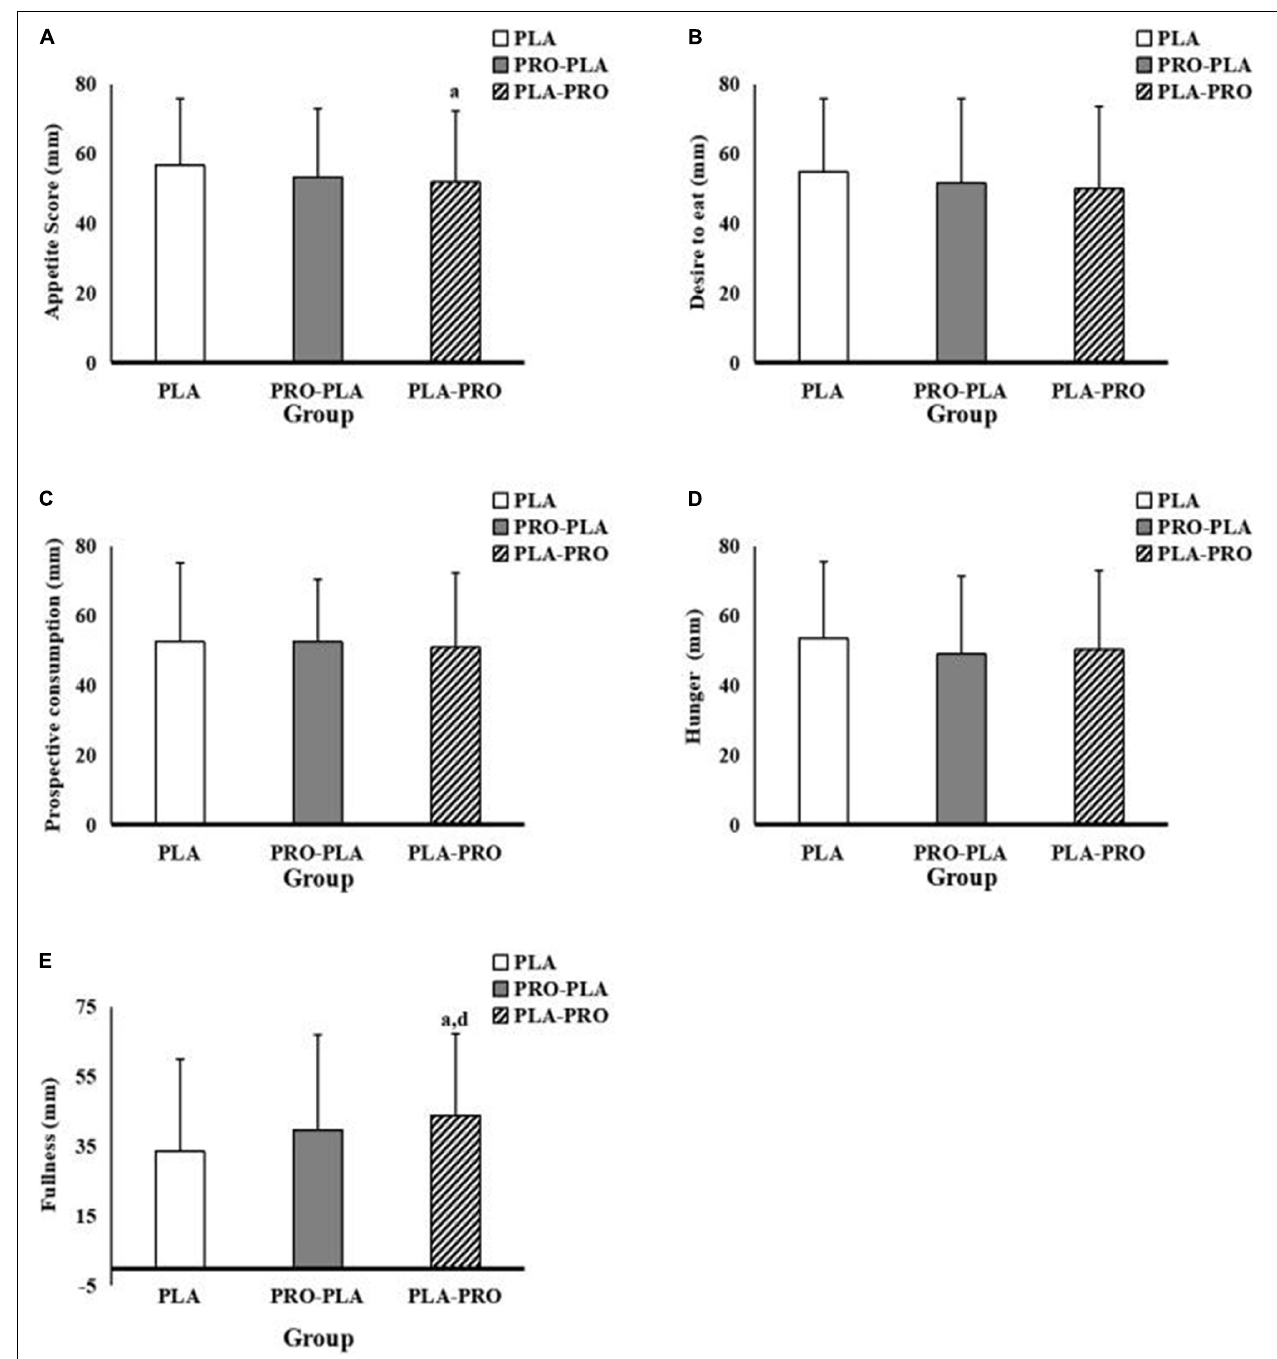
FIGURE 5 | Appetite scores in PLA, PRO-PLA, and PLA-PRO (unit: mm). (A) The appetite score. (B) Desire to eat. (C) Prospective consumption. (D) Hunger. (E) Fullness. a p < 0.05 PLA-PRO VS PLA, adjusted for age, sex, %fat, relativeVO 2max sleep quality, the time of sedentary behavior and moderate and vigorous intensity physical activity in the pre-experiment stage, resistance energy expenditure under each condition (model 1); d p < 0.05 PLA-PRO VS PLA, additionally adjusted for 24-h total energy intake based on model 1 (model 2).